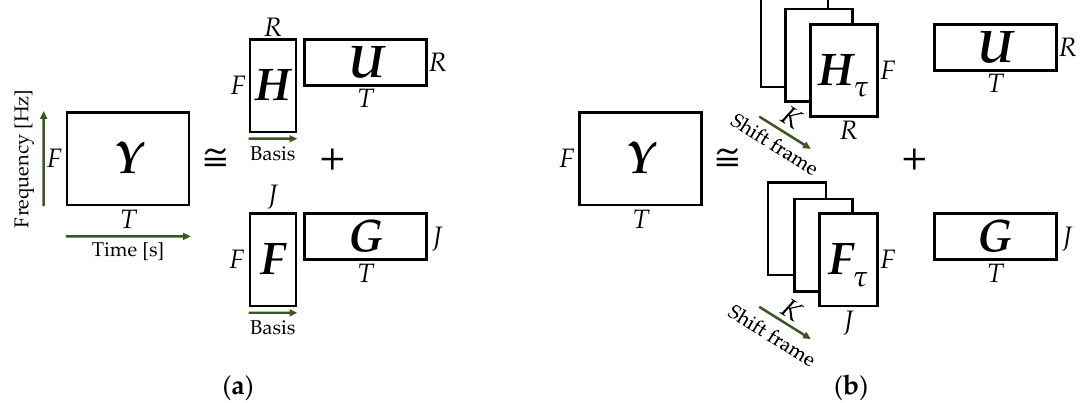
Figure 5. Conceptual diagram of semi-supervised non-negative matrix factorization (SNMF) and semi-supervised convolutive NMF (SCNMF): ( a ) SNMF; ( b ) SCNMF.